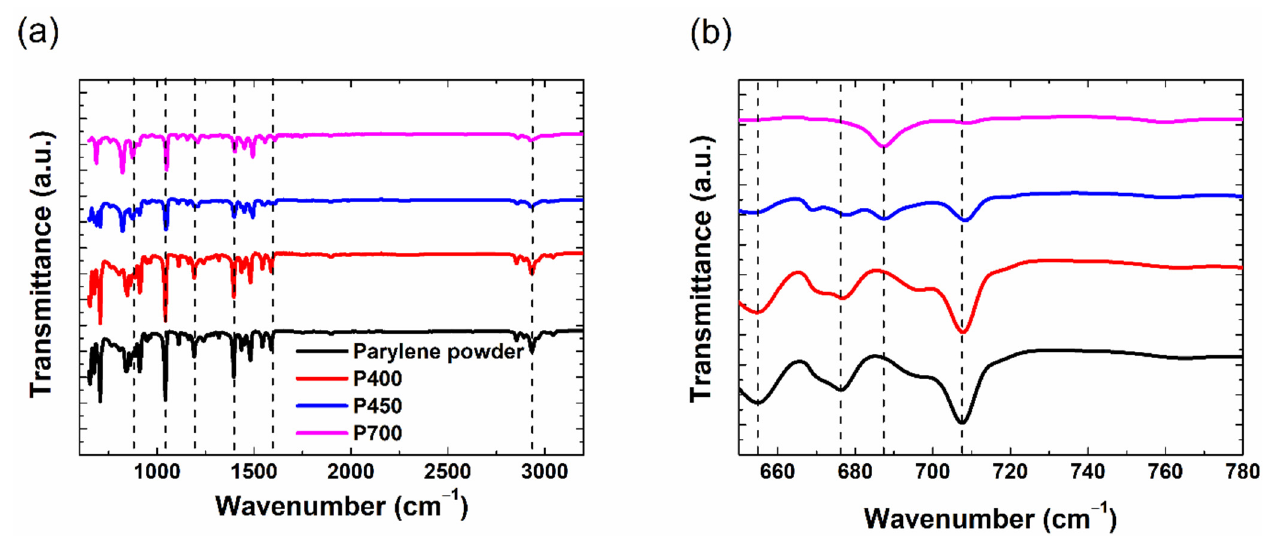
Figure 2. ( a ) FT-IR spectrum of the parylene powder, P400, P450, and P700 parylene films, ( b ) Enlarged FT-IR spectrum at 650–780 cm − 1 of ( a ). The vertical dashed lines are for visual guidance only.